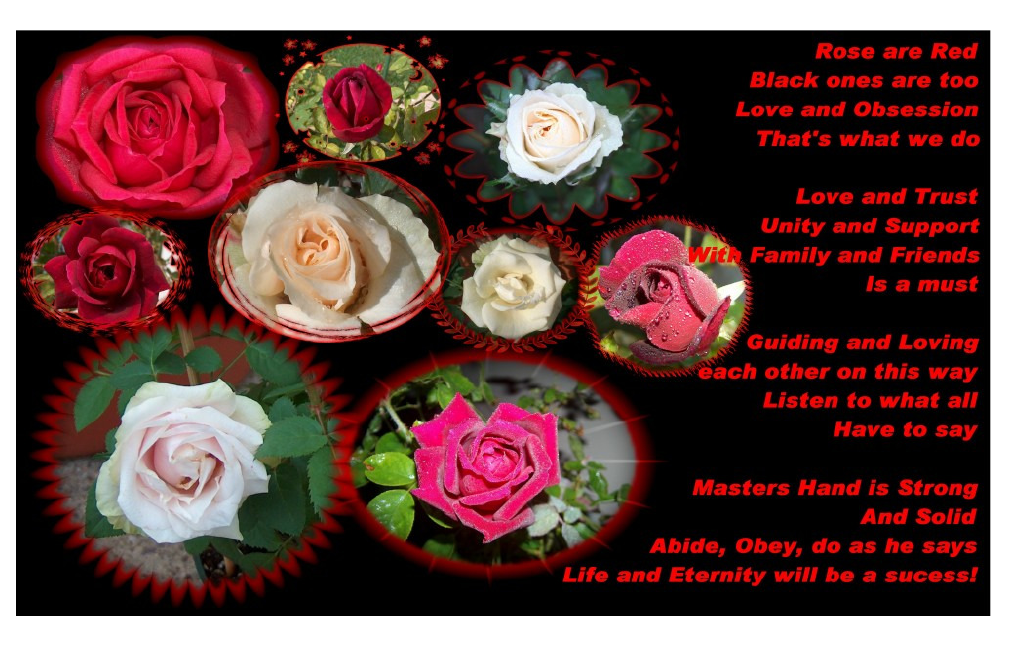
Figure 7. A poem about marriage and rose photographs composed by Rose